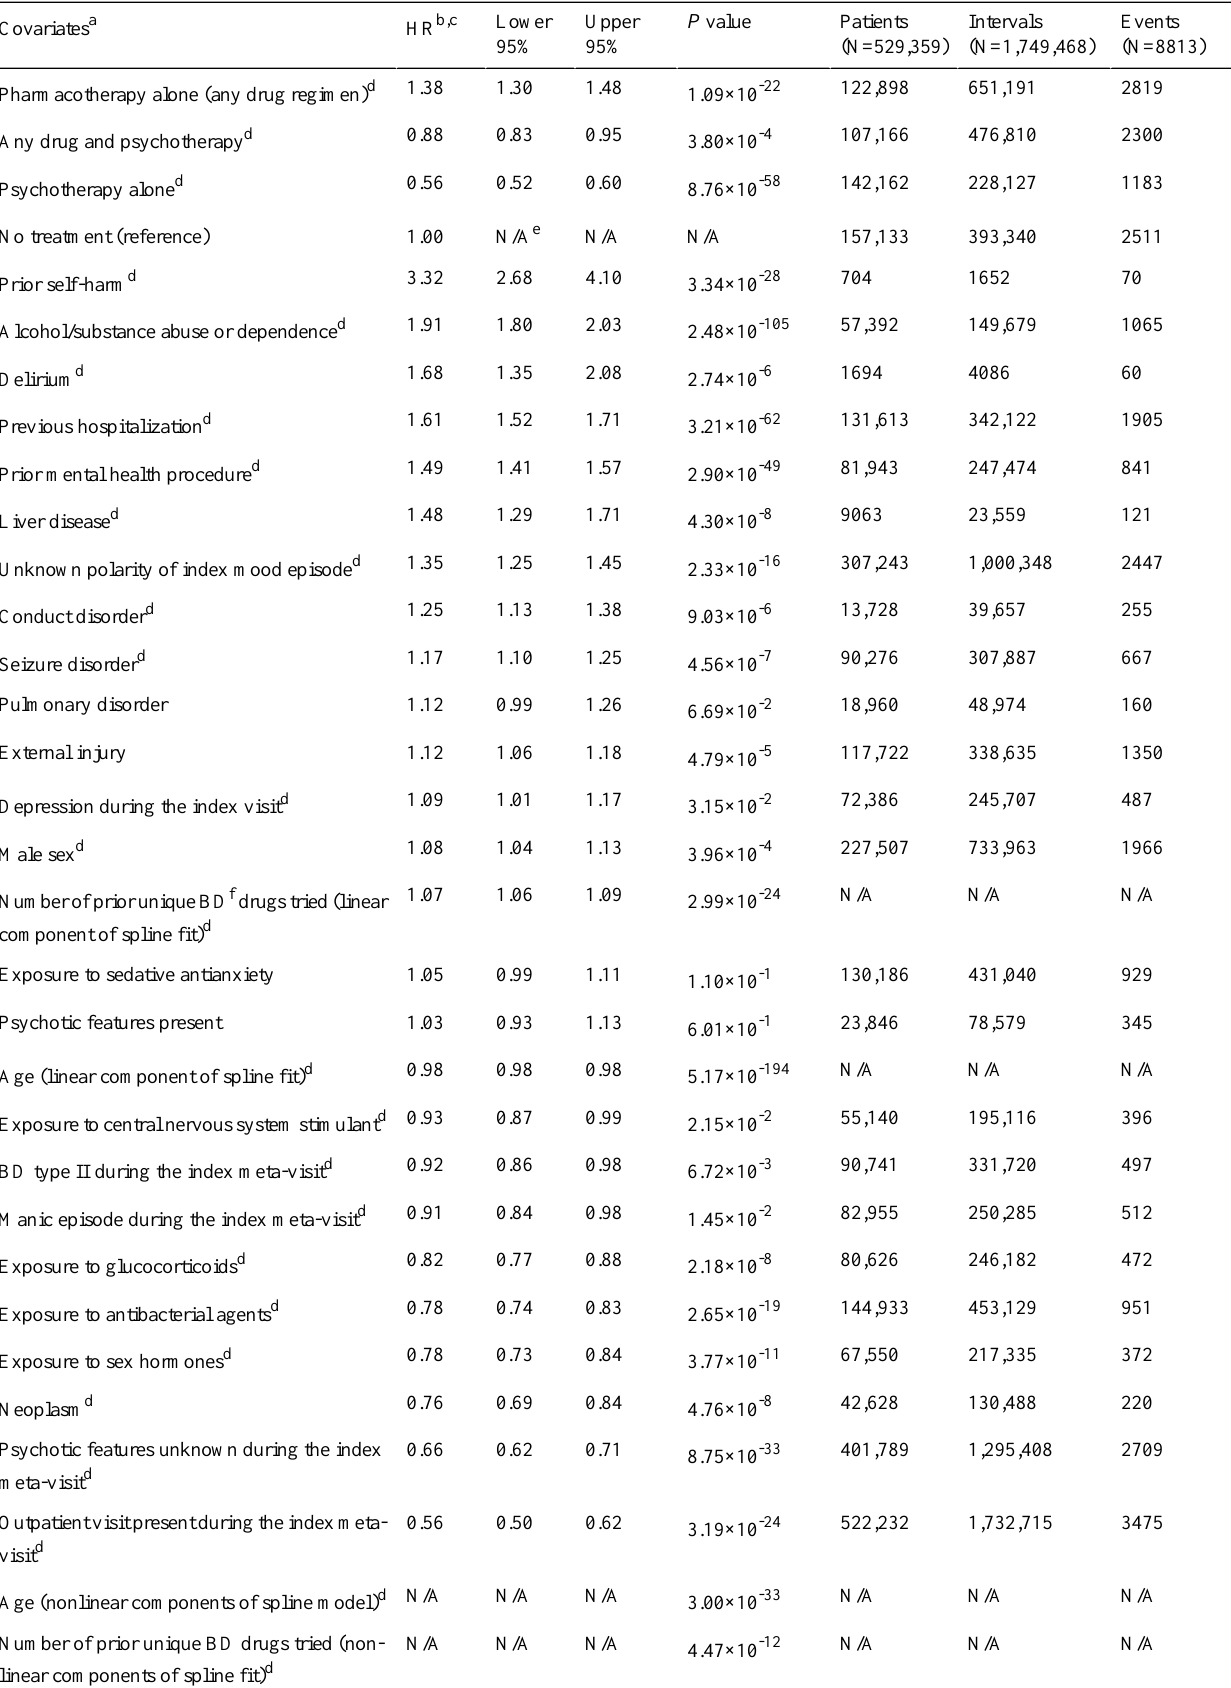
Table 2. Cox regression model comparing “pharmacotherapy” (as a single category) and “psychotherapy” (psychosocial interventions) to “no treatment” (no drugs and no psychotherapy) for the risk of subsequent coded and/or imputed self-harm in patients with bipolar disorder of all